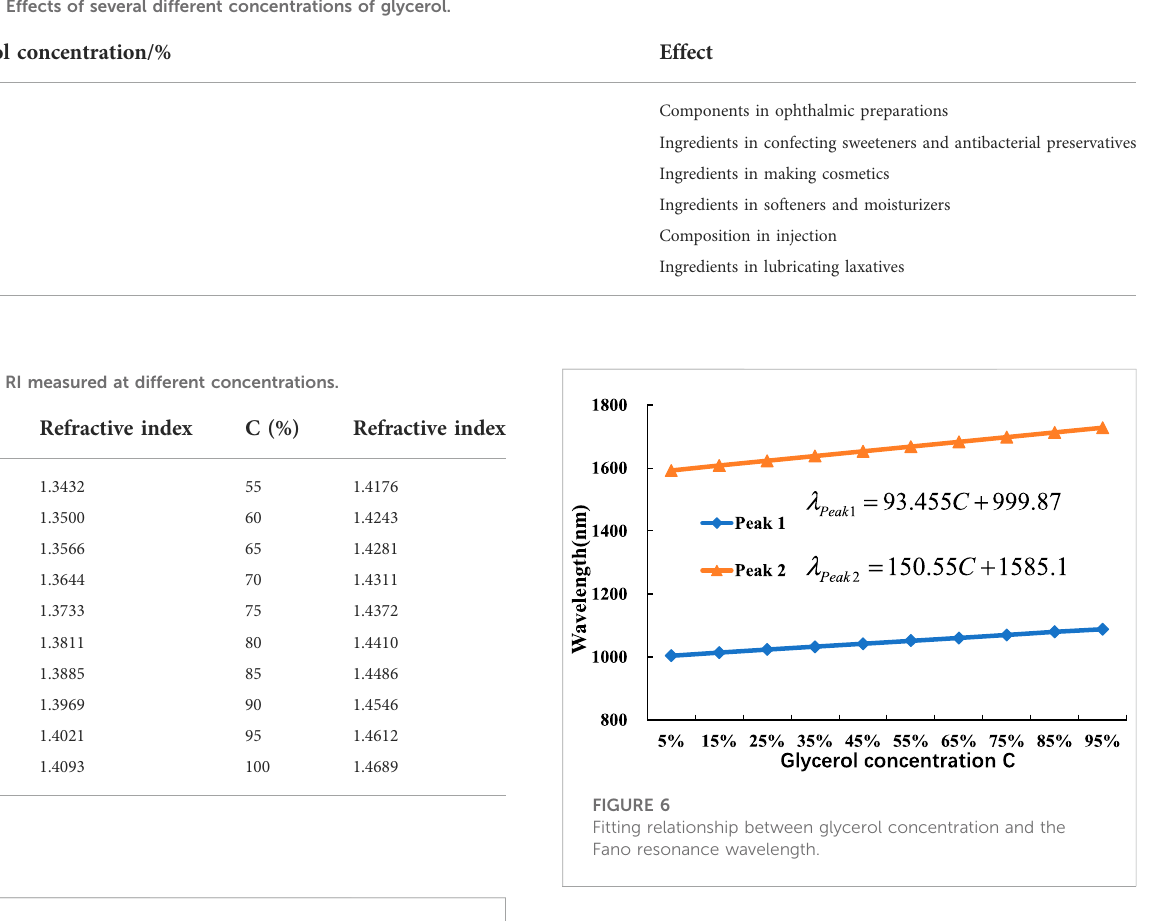
TABLE 4 Effects of several different concentrations of glycerol.